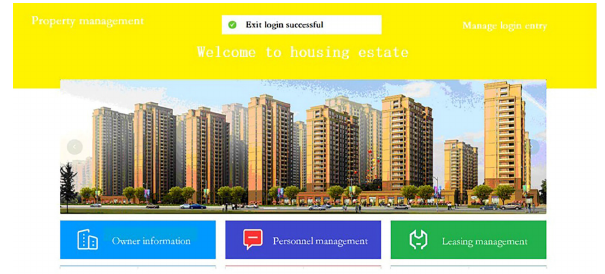
Fig. 3 General diagram of the residential property management information system.